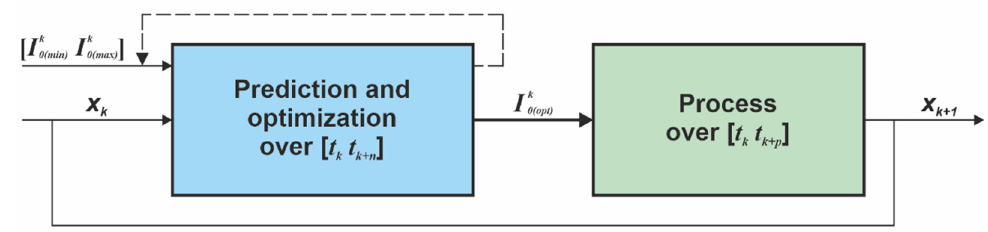
Figure 6. The closed ‐ loop control scheme of the photosynthetic growth process.